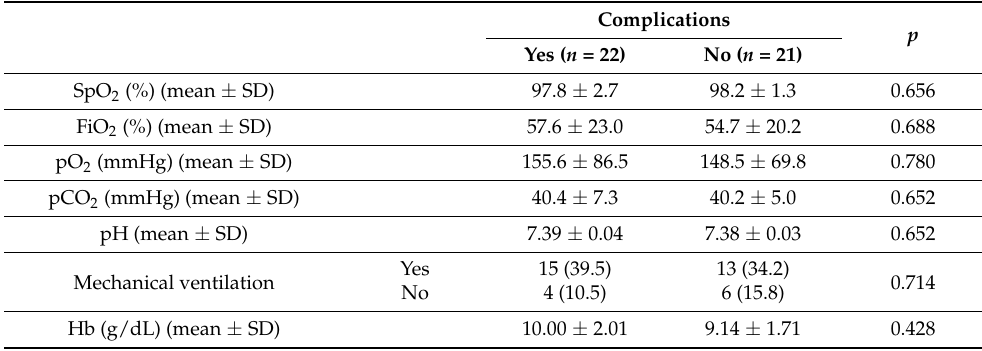
Table 11. Univariate Analysis of Variables from ICU Patients on